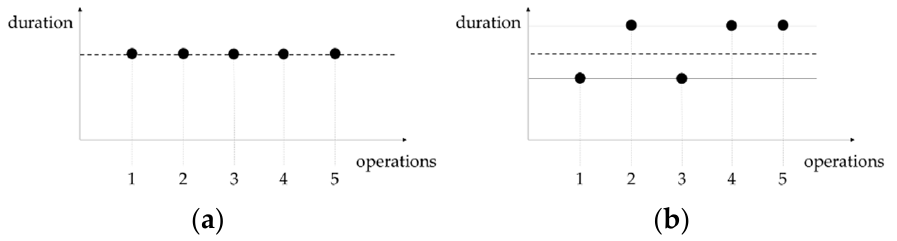
Figure 4. ( a ) Operations of the same duration. ( b ) Operations of similar duration.